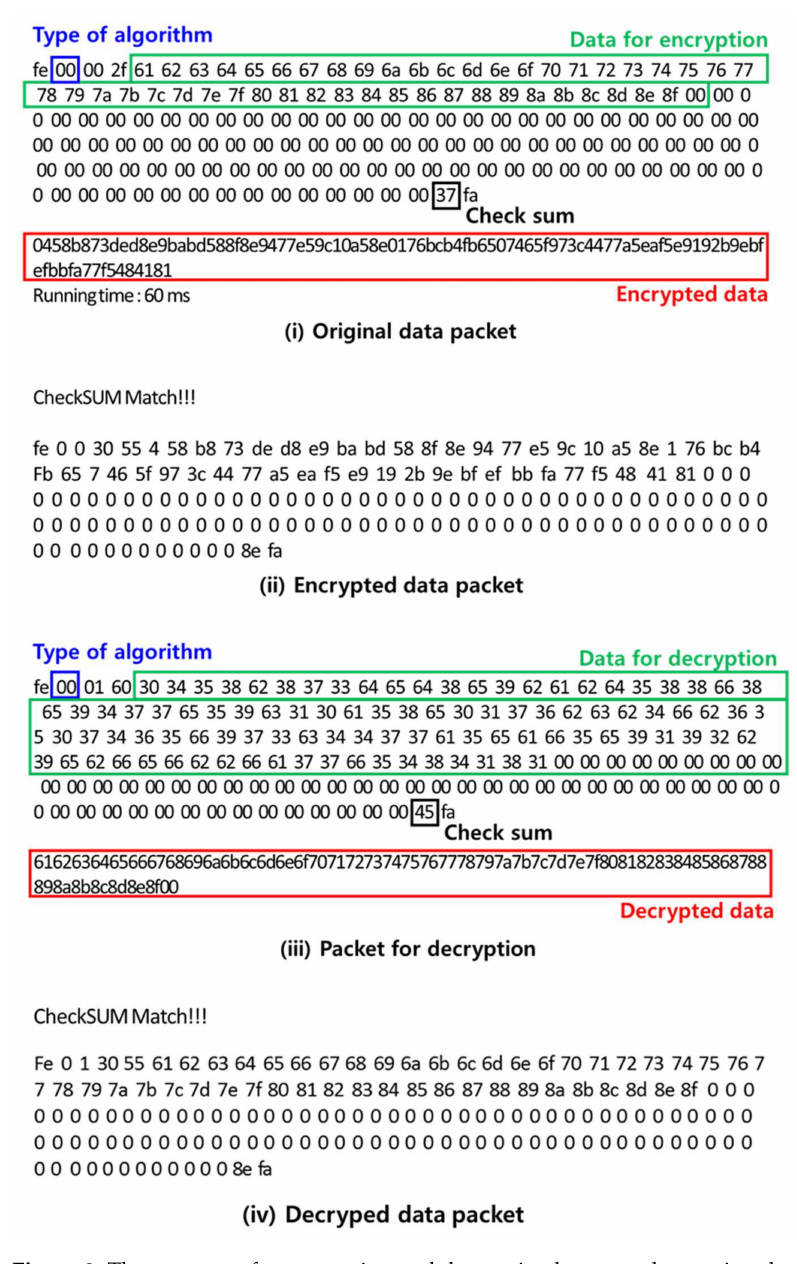
Figure 9. The processes for encryption and decryption between the sensing device and